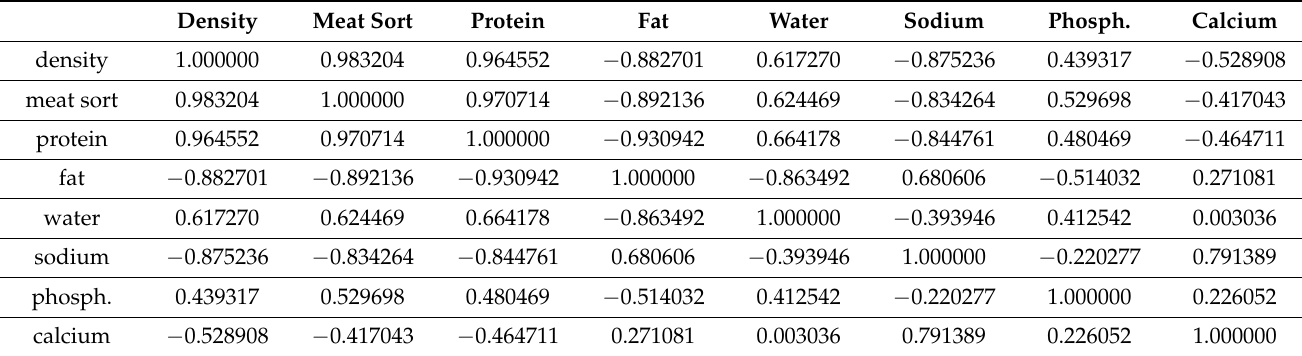
Table 2. Cross-correlation matrix (Pearson’s correlation coefficients r ) for physicochemical parameters of the investigated MSM.